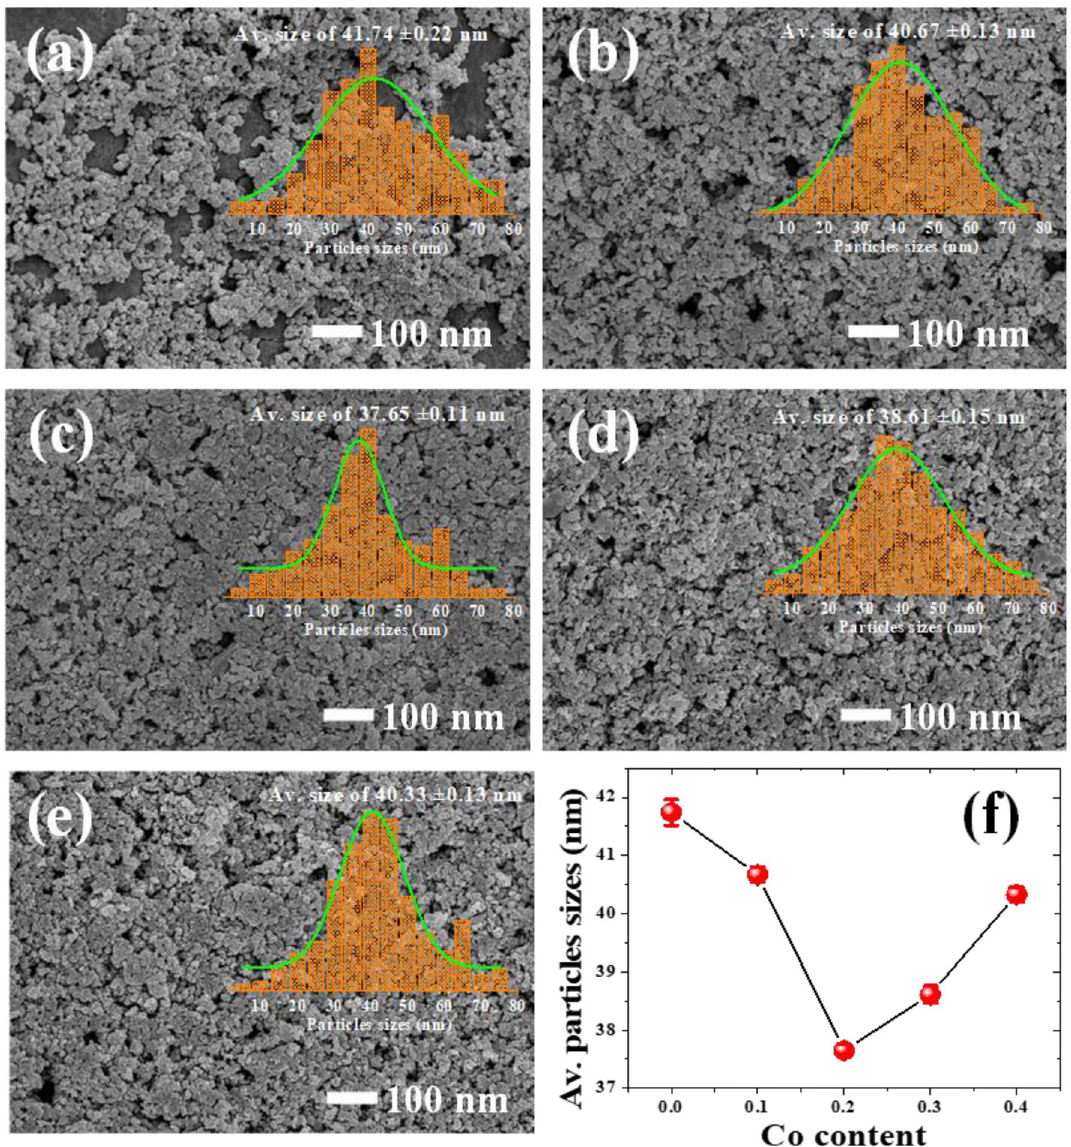
Figure 5. SEM images with histograms of the particle size distribution of Co x Zn 1−x Fe 2 O 4 NPs ( a ) x = 0.0, ( b ) x = 0.1, ( c ) x = 0.2, ( d ) x = 0.3 and ( e ) x = 0.4. ( f ) Plot of Av. particles sizes vs . Co